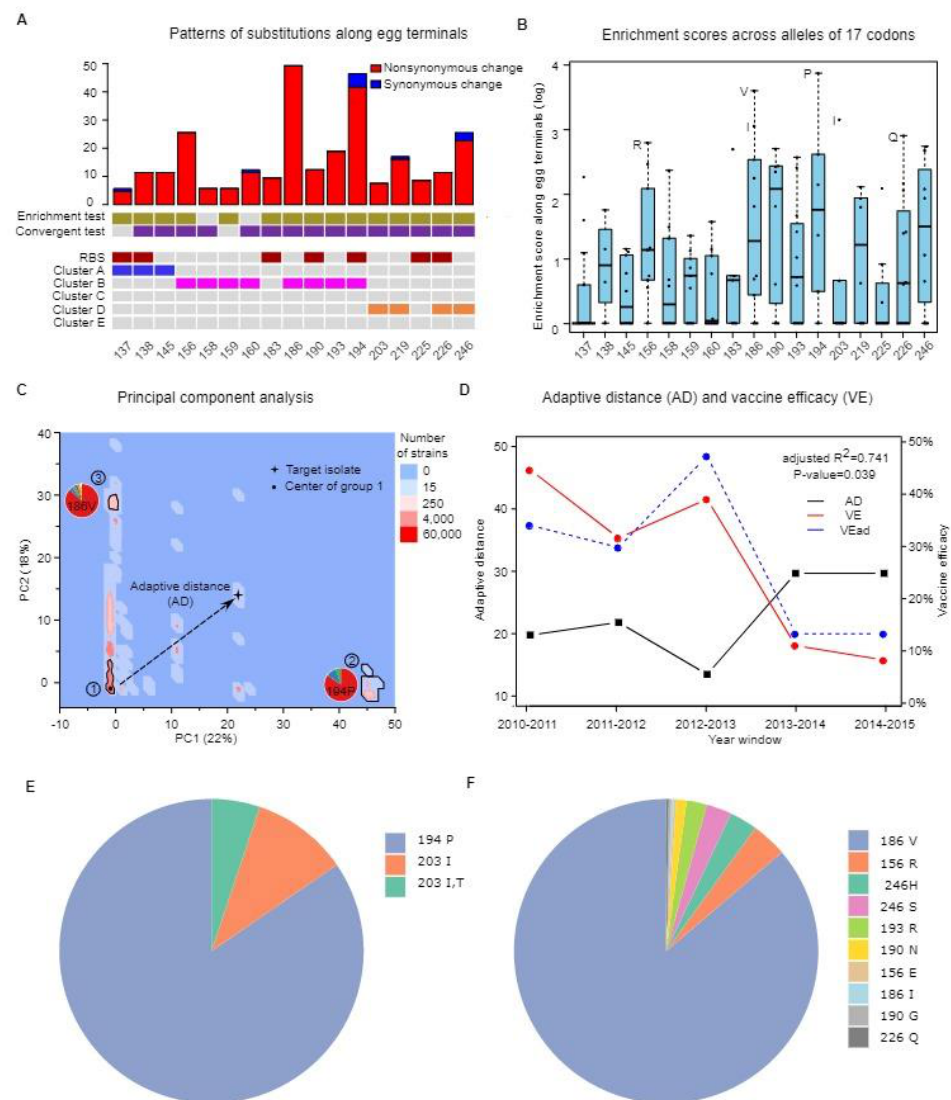
Figure 1. Statistical approaches for characterizing egg passage adaptation. ( A ) Numbers of nonsyn- onymous and synonymous changes at HA1 codons responsible for egg passage adaptation. The codons showing statistical significance from the enrichment and convergent tests ( q -value < 0.05) are labelled in yellow and purple, respectively. Codons located in functional domains such as receptor binding sites (RBS), antigenic epitope A, B and D will be labeled in red, blue, violet and orange color respectively. ( B ) Enrichment scores across codons responsible for the egg passage adaptation. Alleles with enrichment scores higher than 20 are labeled. ( C ) Principal component analysis of the 17-dimensional space of ES scores for all the sequences. Discrete subgroups of sequences carrying different passage-related alleles distribute in clusters away from the major cluster. Pie charts display major adaptive alleles in different groups. For example, 194P and 186V are the dominant adaptive alleles observed in cluster 2 and 3, respectively. Adaptive distance (AD) is defined as the distance between the target strain (e.g., CVV) and the centroid of the major cluster for most of the non-egg sequences (i.e., group 1). ( D ) Correlation between the adaptive distance (AD) and vaccine efficacy (VE) between influenza seasons from 2010 to 2015. The predicted VE ad is drawn as the dashed line. ( E ) Proportion of different alleles with enrichment score >10 in the cluster 2 of the PCA map (panel ( C )). ( F ) Proportion of different alleles with enrichment score >10 in the cluster 3 of the PCA map (panel ( C